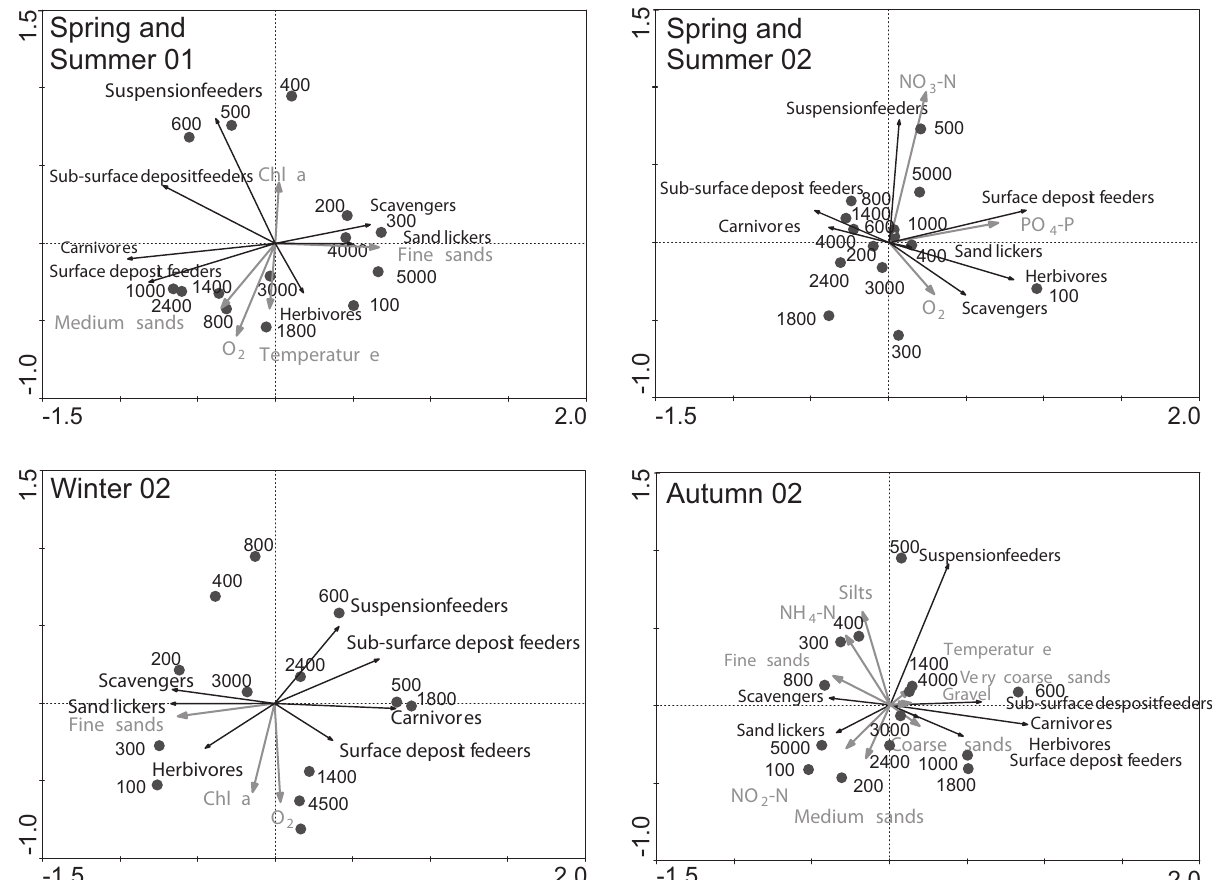
Fig. 6 . – rDa ordination triplot for the feeding guilds. Circles, station positions within the ordination space; black vector lines, feeding guild density; grey vector lines, the relationship of the significant environmental variables to the ordination axis; the line’s length is proportional to its relative